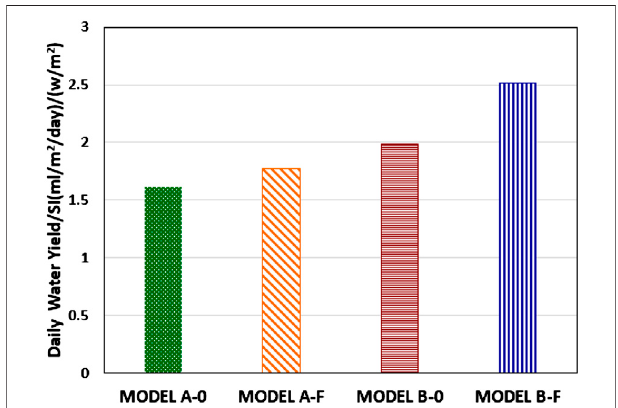
FIGURE 4 | Daily water yield per average solar irradiation